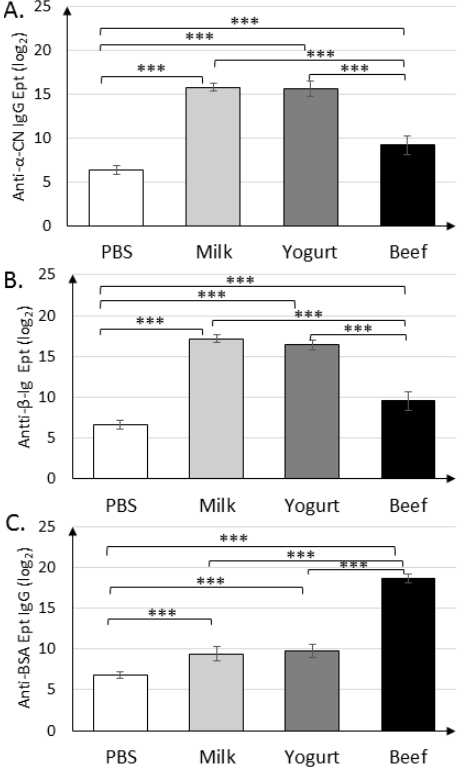
Figure 3. Serum levels of IgGs against α-CN ( A ), β-lg ( B ), and BSA ( C ) on day 30 in mice from the Milk, Yogurt, Beef, and PBS groups. Data are the mean ( n = 10) ± SD, *** p < 0.001, one-way ANOVA with Tukey post-hoc tests.